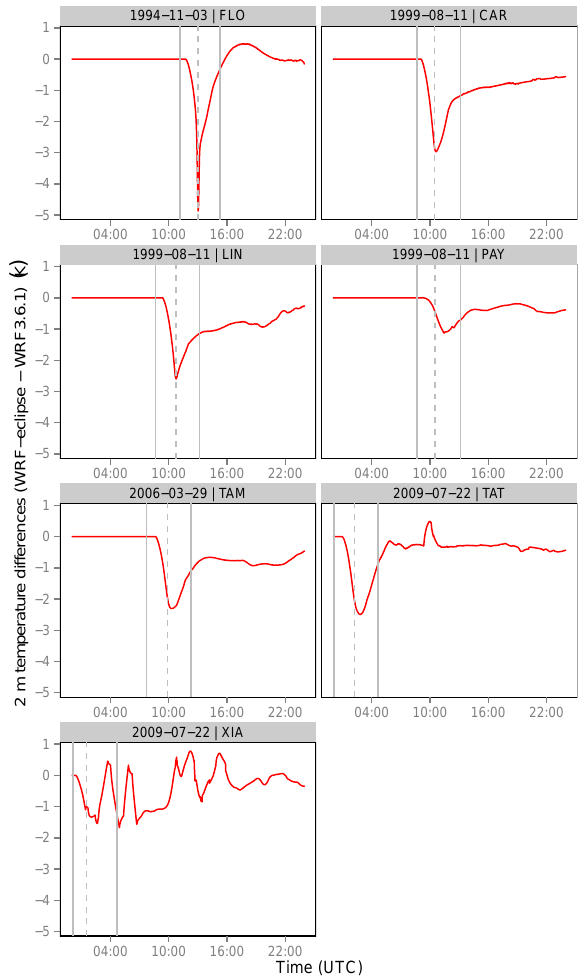
Figure 5. Temperature differences at 2m for each episode and site. Each total solar eclipse event is labeled with the date. The first and second vertical gray solid lines indicate the time of FCTD and LCTD, respectively. The dashed vertical gray line shows the time of maximum obscuration. All results are expressed with 1min time